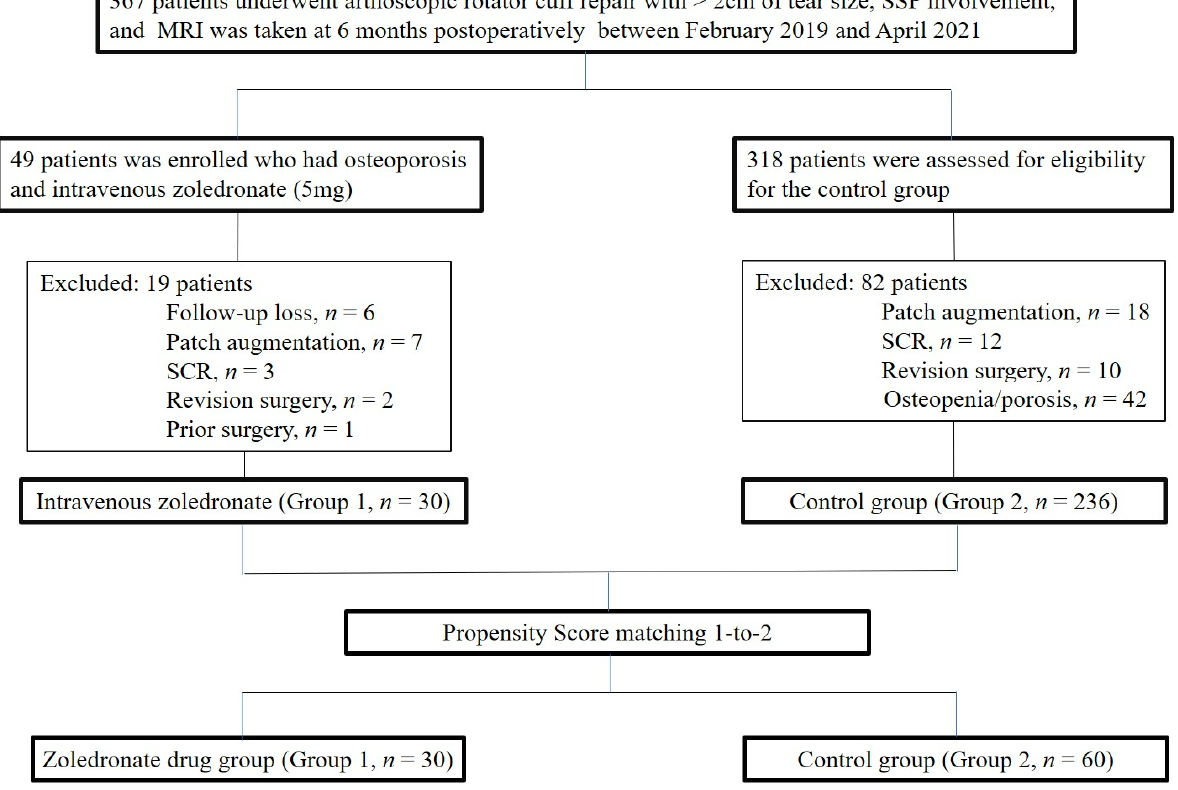
Figure 1. Flow diagram illustrating included and excluded patients.